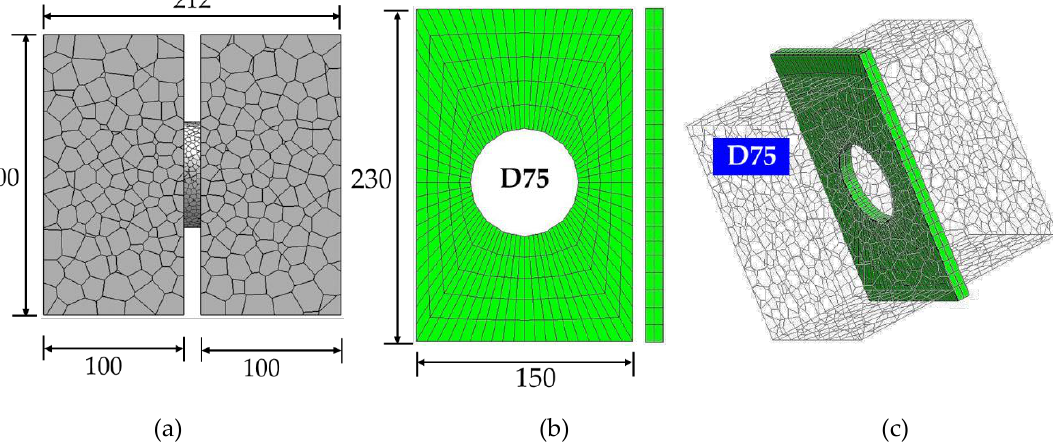
Figure 13. The analytical model of the specimen with a 75-mm diameter of the hole (unit: mm): ( a ) Modeling of the concrete dowel and the side blocks; ( b ) Modeling of the perforated steel plate; ( c ) Analytical model of the PBL shear connector.